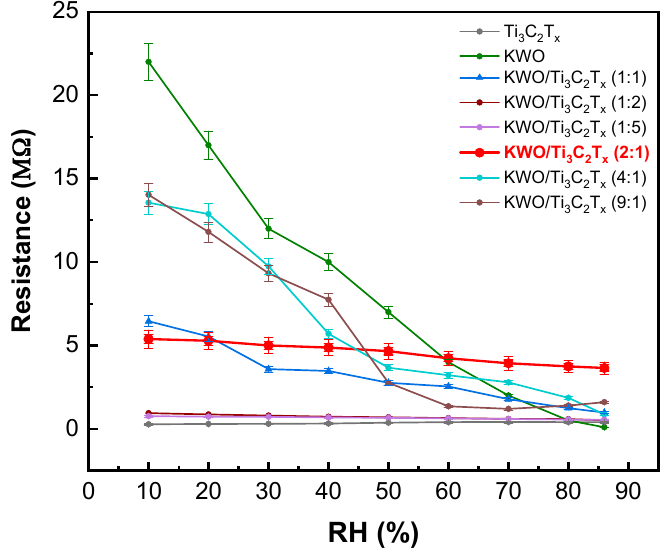
Figure 5. Resistance and RH relationship based on variable nanomaterials: Ti 3 C 2 T x nanosheets, KWO nanorods, KWO/Ti 3 C 2 T x (1:2), KWO/Ti 3 C 2 T x (2:1), KWO/Ti 3 C 2 T x (1:1), KWO/Ti 3 C 2 T x (1:5), KWO/Ti 3 C 2 T x (4:1), and KWO/Ti 3 C 2 T x (9:1).